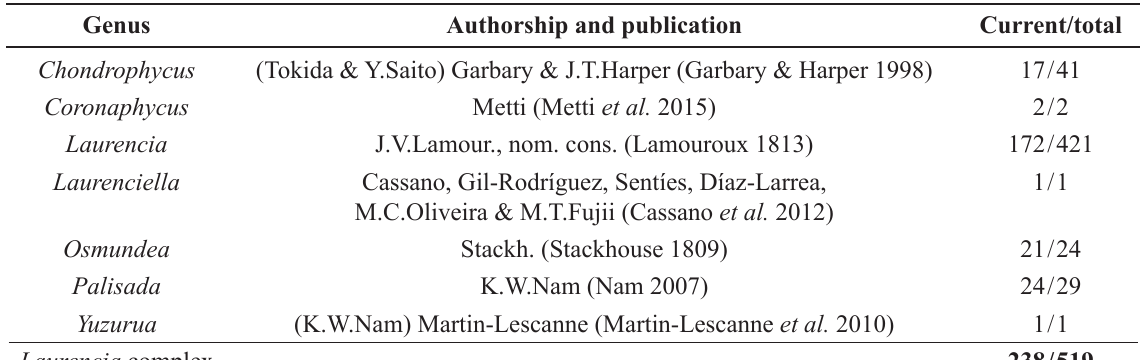
Table 1. Number of specific and infraspecific taxa currently recognized / total number of taxa, according to AlgaeBase (Guiry & Guiry 2016), for each genus of the Laurencia